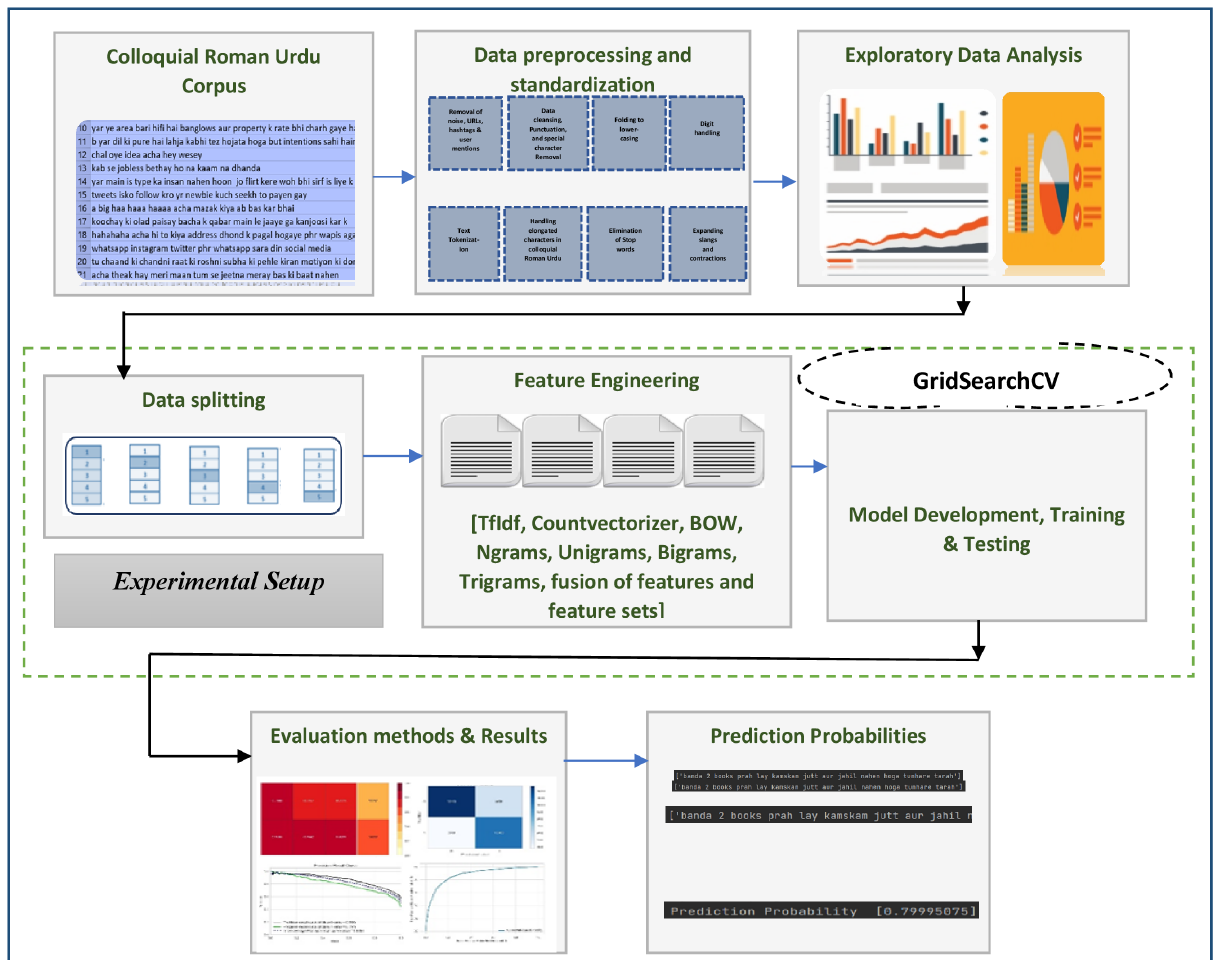
Figure 1. Proposed approach for detecting cyberbullying patterns in Colloquial Roman